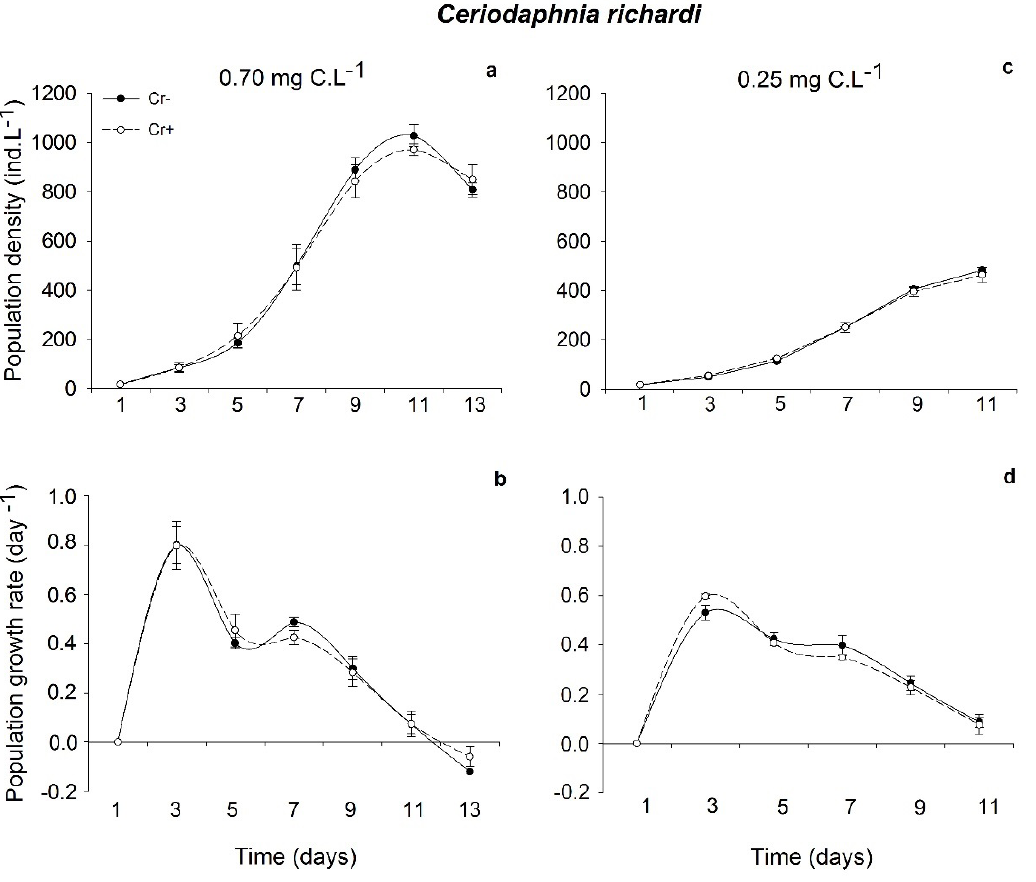
Figure 6. Population growth curves (a, b) and population growth rate (r) per day (c, d) of C. richardi alone (Cr-) and cultured together (Cr+) in high (0.70 mg C.L -1 ) and low (0.25 mg C.L -1 ) food concentrations, respectively. The vertical bars represent the standard error of the mean (±) based on three